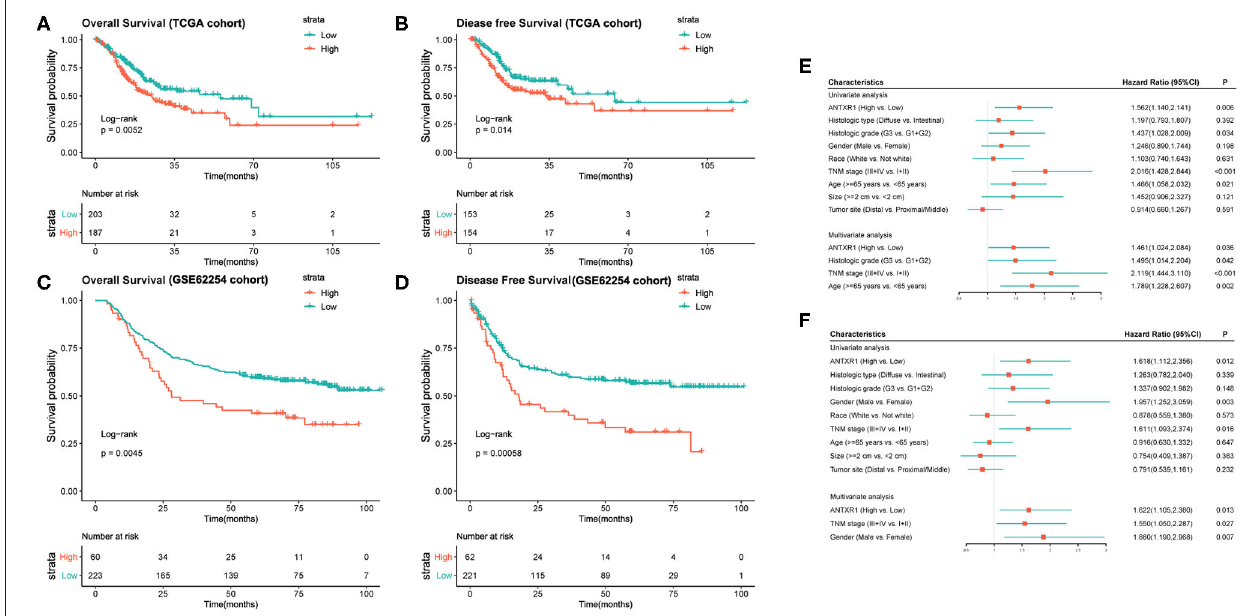
FIGURE 2 | High expression of ANTXR1 predicts adverse clinical outcomes of gastric cancer patients by applying Kaplan–Meier survival analysis. (A,B) Based on TCGA datasets. (C,D) Based on GSE62254 cohort. Univariate and multivariate analysis of clinical parameters associated with overall survival (E) and disease-free survival (F) .